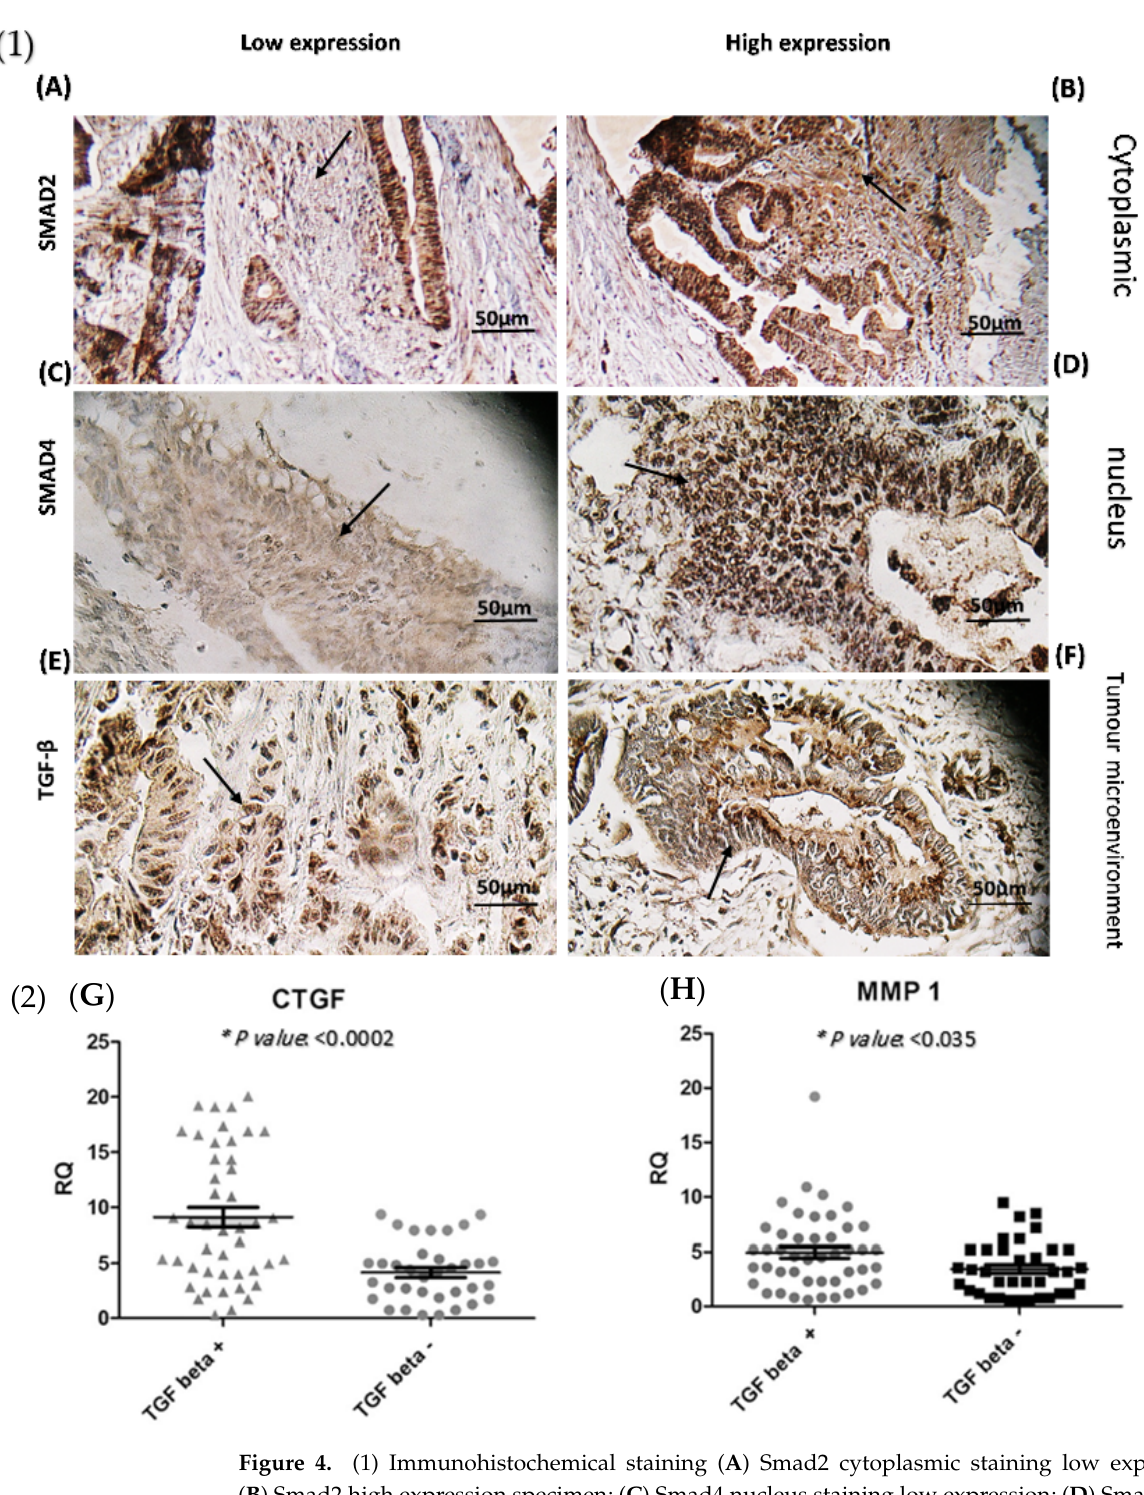
Figure 4. (1) Immunohistochemical staining ( A ) Smad2 cytoplasmic staining low expression; ( B ) Smad2 high expression specimen; ( C ) Smad4 nucleus staining low expression; ( D ) Smad4 high expression specimen; ( E ) IHC staining of TGF- β in Low expressed sample; and ( F ) High TGF- β ex- pression. (2) Association between ( G ) CTGF expression level (* p < 0.0002) and ( H ) MMP-1 (* p < 0.035) through TGF- β pathway. * RQ related to Relative quantification.